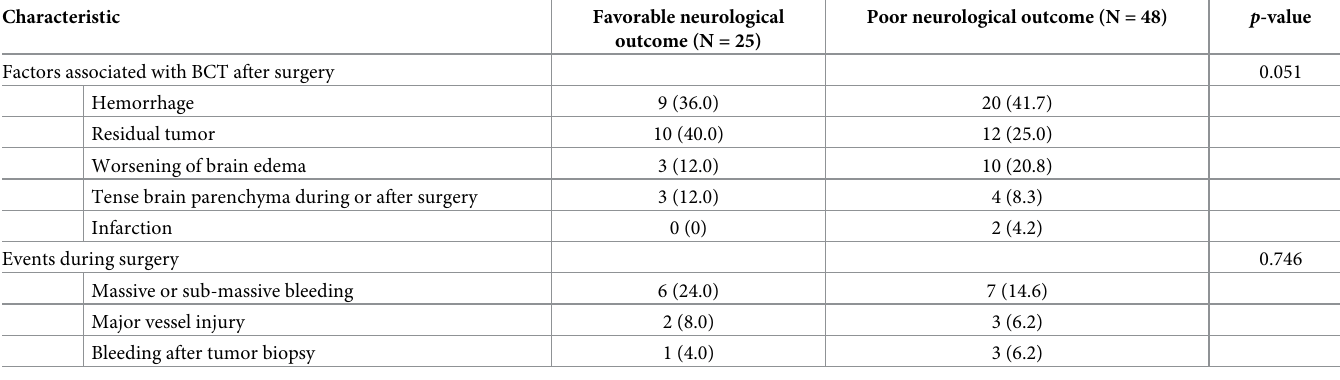
Table 3. Factors associated with barbiturate coma therapy during tumor surgery.